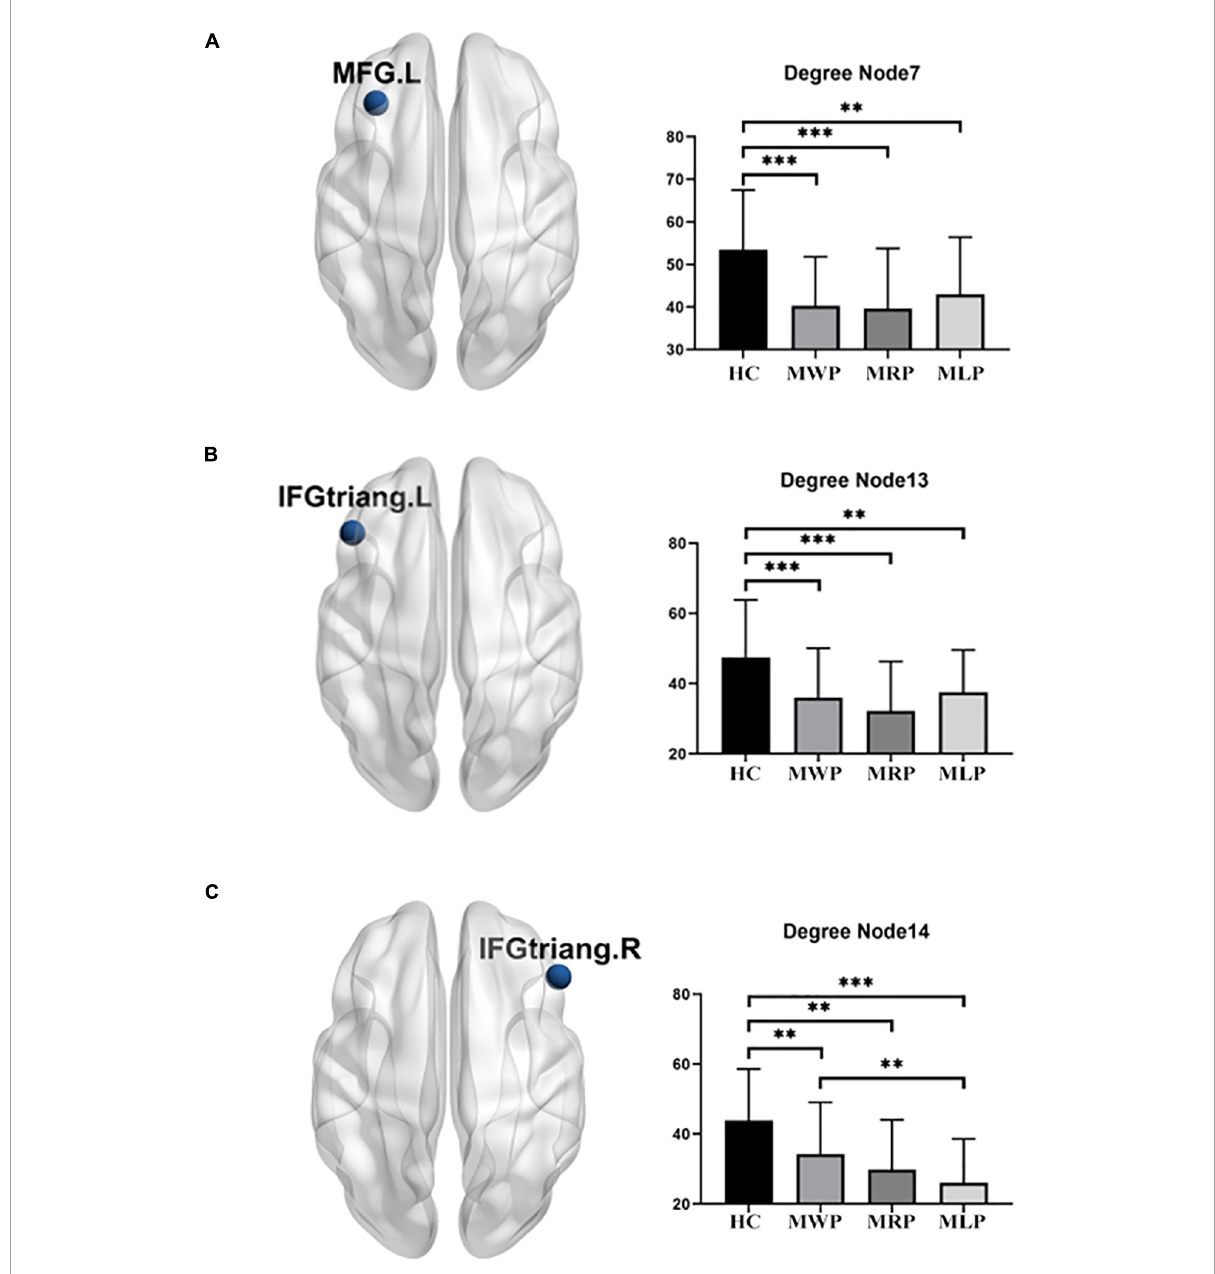
FIGURE6 Comparison of degrees in the local network. In comparison with the healthy controls (HCs), MMD patients without paresthesia (MWP), patients with right-limb paresthesia (MRP), and patients with left-limb paresthesia (MLP) showed reductions in degree in the following brain regions: MFG.L (A) : MLP > MWP > MRP; IFGtriang.L (B) : MLP > MWP > MRP; and IFGtriang.R (C) : MWP > MRP > MLP. Asterisk ( ∗ ) denotes results without family-wise error (FWE) correction, ∗∗ p < 0.05 after FWE correction, and ∗∗∗ p < 0.01 after FWE